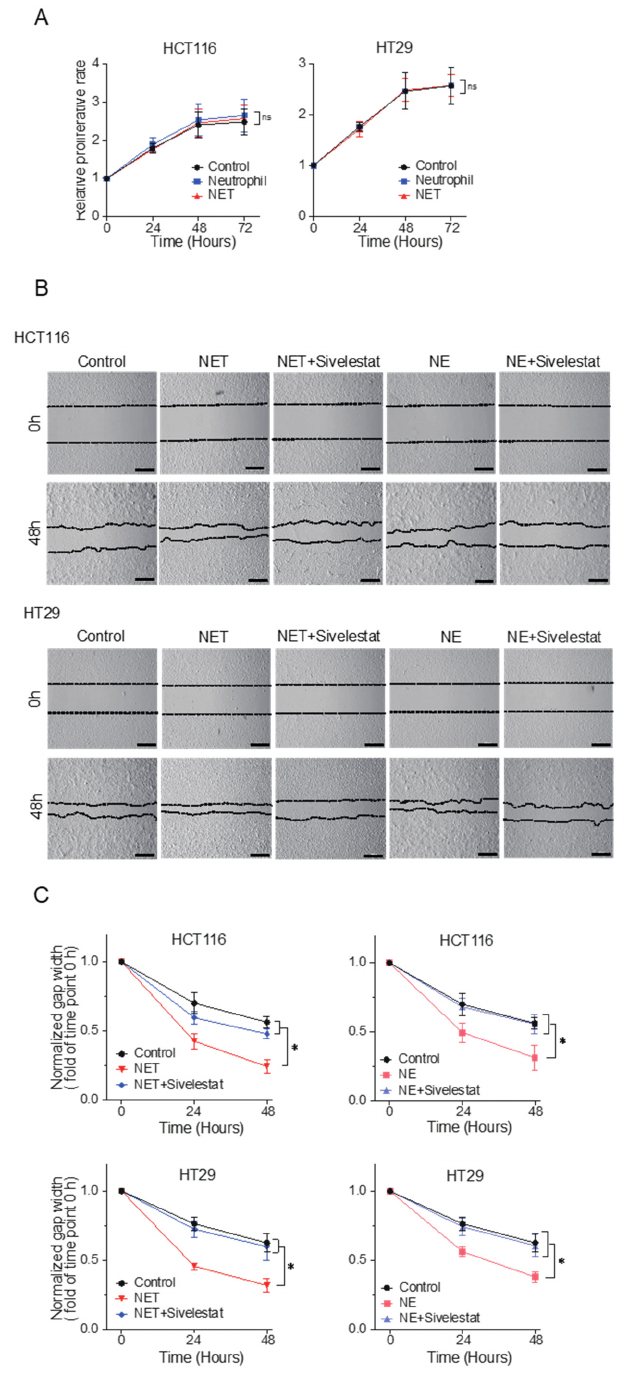
Figure 2. NETs accelerate the migration of CRC cells through the release of NE in vitro. ( A ) Cell proliferation assay using HCT116 and HT29 cells. Cells were incubated with NET-conditioned medium (NET-CM) or neutrophil control medium and were analyzed at 0, 24, 48 and 72 hours. The absorbance at time 0 was normalized to 1. Mean: bars ± standard error of the mean (SEM). n = 3. ns: not significant with Student’s t test. ( B ) Cell migration assay using scratch wound healing. HCT116 and HT29 cells were incubated with NET-CM or neutrophil control medium and were treated with 100 µ M of sivelestat. Representative images are shown. Scale bars, 500 µ m. ( C ) Wound width was measured at 0, 24 and 48 hours. Normalized gap width at hour 0 was 1. Mean: bars ± standard deviation (SD). n = 6. * p < 0.05 with Student’s t